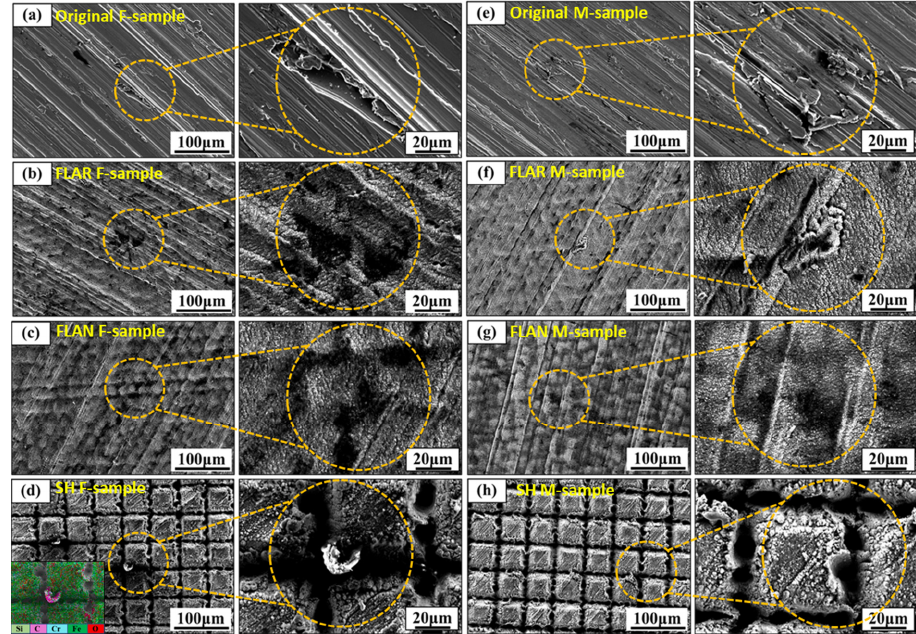
Figure 9. Surface morphologies of ( a ) original F-samples, ( b ) FLAR F-samples, ( c ) FLAN F-samples, ( d ) SH F-samples, ( e ) original M-samples, ( f ) FLAR M-samples, ( g ) FLAN M-samples, and ( h ) SH M-samples after being immersed in 0.5 mol/L NaCl solution for 72 h.